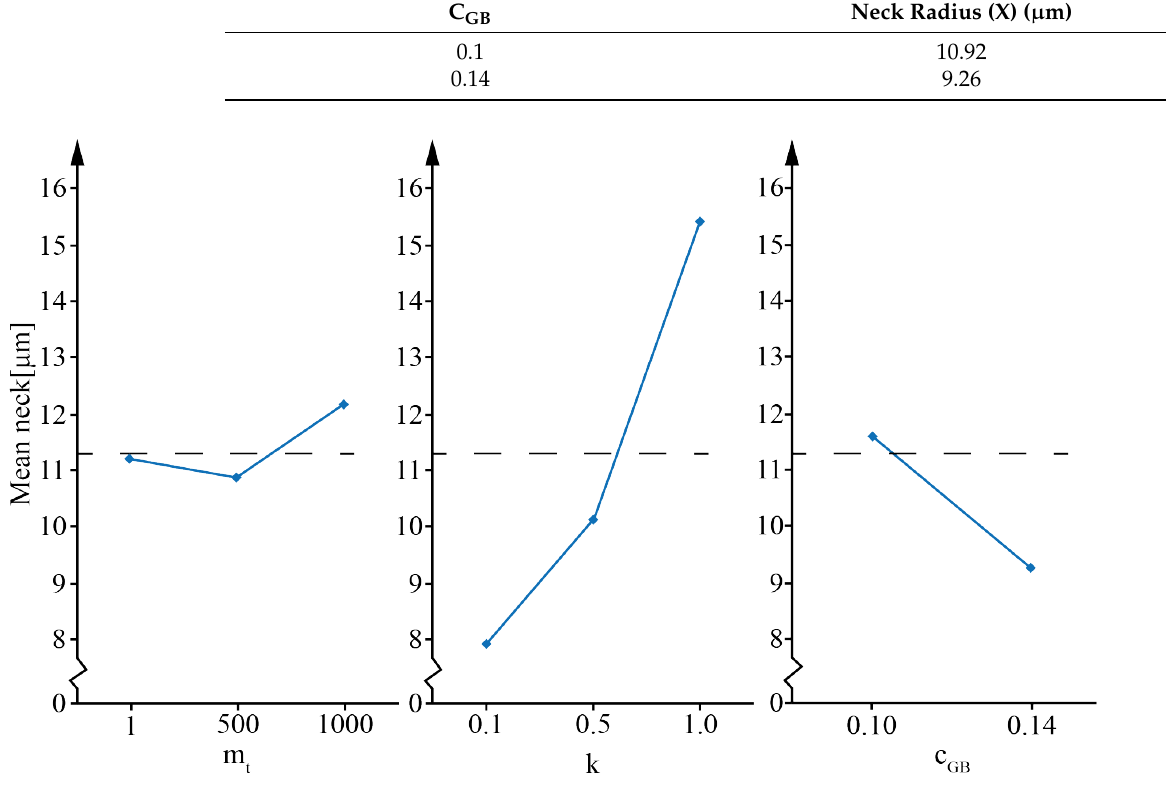
Figure 3. Main effect plot of the RBM parameters under consideration on the dimension of the neck radius at the end of the simulation.